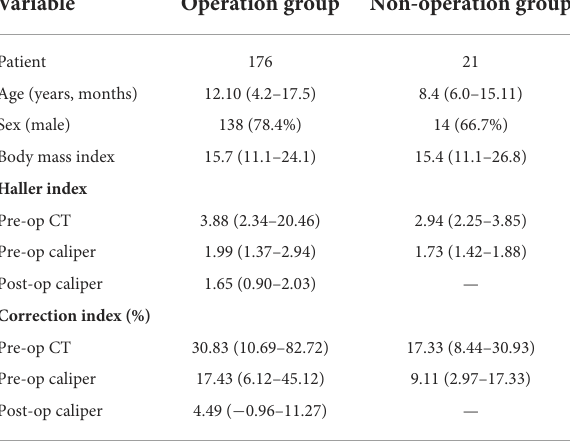
TABLE 1 Demographics and measurements stratified by study groups. TABLE 2 Demographics and measurements stratified by population